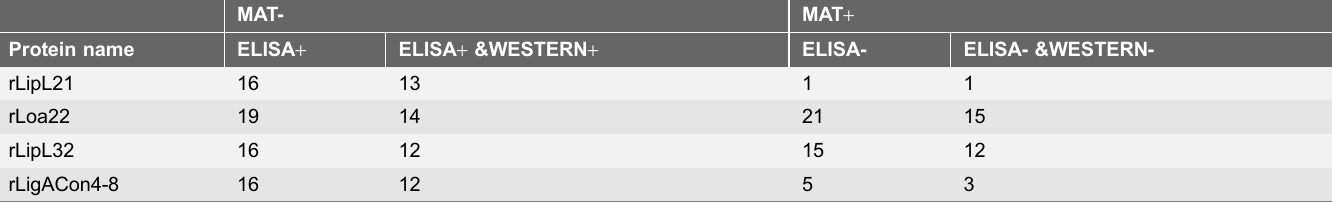
Table 5. Comparison of MAT negative and ELISA and Western blot analysis positive or MAT positive, but ELISA and Western blot analysis negative. MAT- MAT + Protein name ELISA + ELISA + &WESTERN + ELISA- ELISA- &WESTERN- rLipL21 16 13 1 1 rLoa22 19 14 21 15 rLipL32 16 12 15 12 rLigACon4-8 16 12 5 3